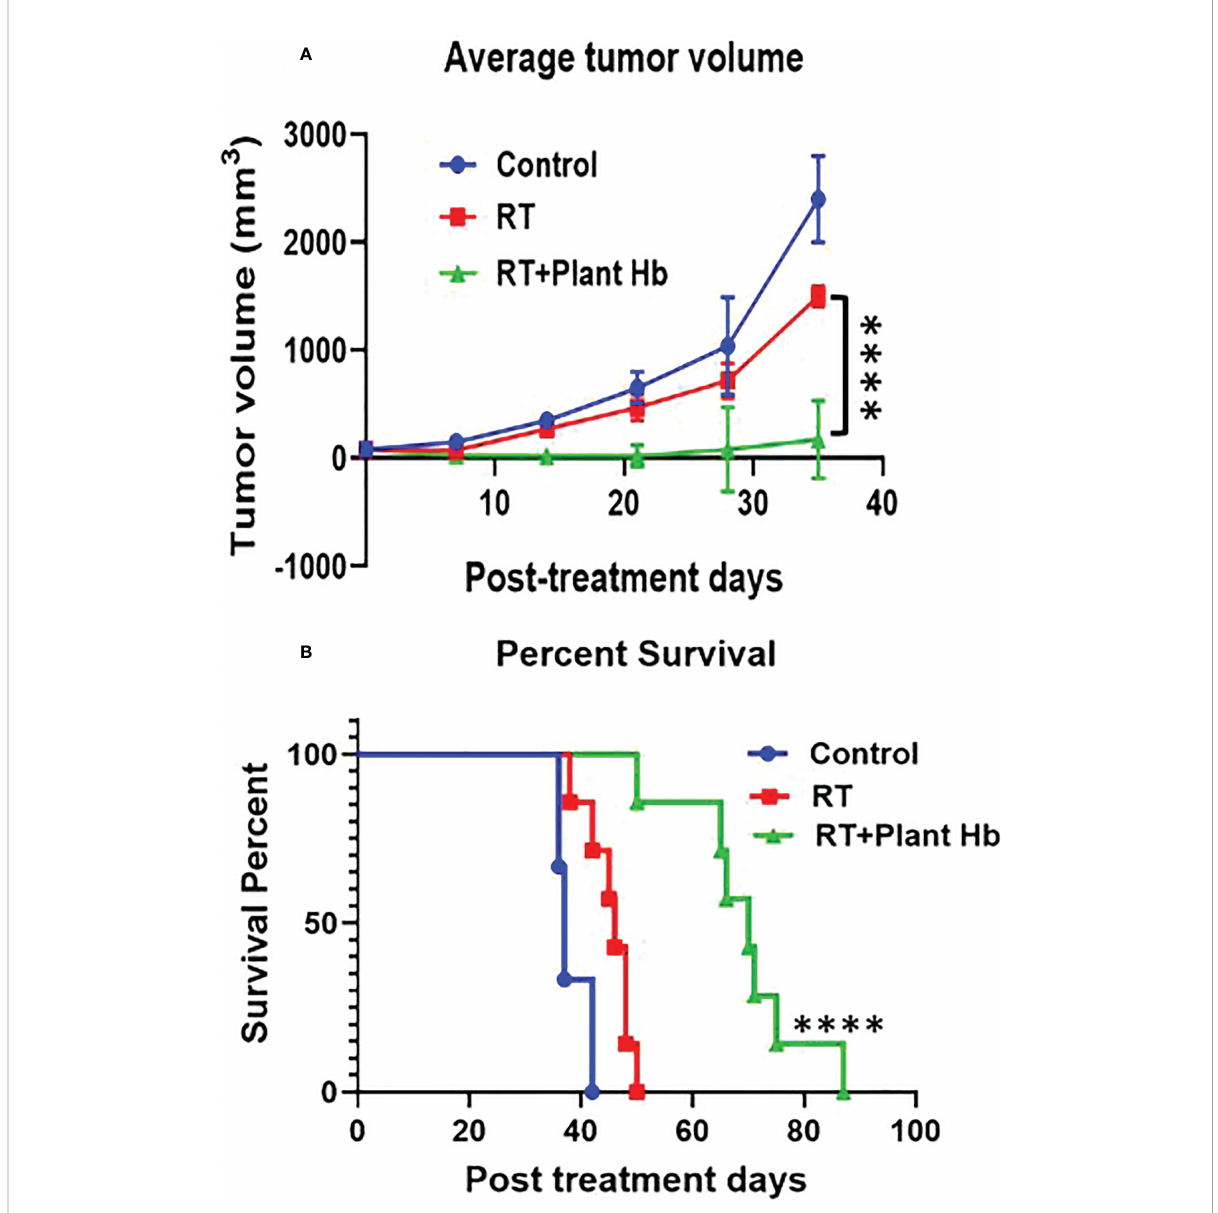
FIGURE 4 Plant Hemoglobin as a Radiation Therapy Enhancer. Signi fi cant reduction of tumor volume (n=6) (A) and increased survival (n=7) (B) in mice with pancreatic adenocarcinoma after treatment with plant hemoglobin and adjuvant radiation therapy